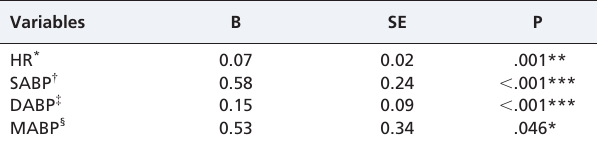
Table 4 - Time-series regression analysis of the associations of noise level (Leq) with heart rate and blood pressure (n=